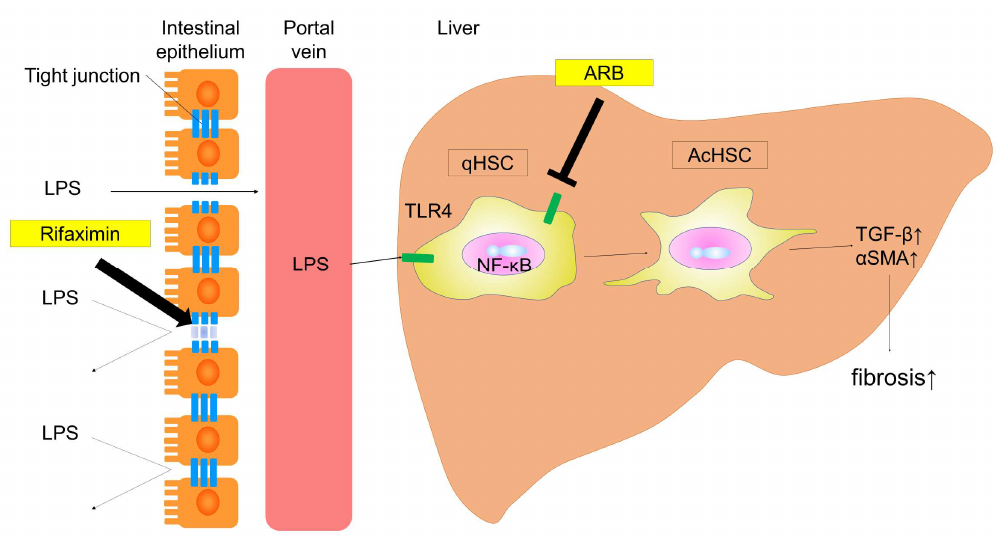
Figure 9. Schema of this experiment. This schema presents the mechanisms by which ARB and RFX prevent the progression of NASH fibrosis through the gut–liver axis. ARB inhibit the activation of hepatic stellate cells by blocking TLR4 and AT-II type 1 receptor, and RFX improves intestinal permeability. Combining ARB and RFX suppresses liver fibrosis through different mechanisms. (Thin arrow; transition to the next. Thick arrow; activation of tight junction protein.)